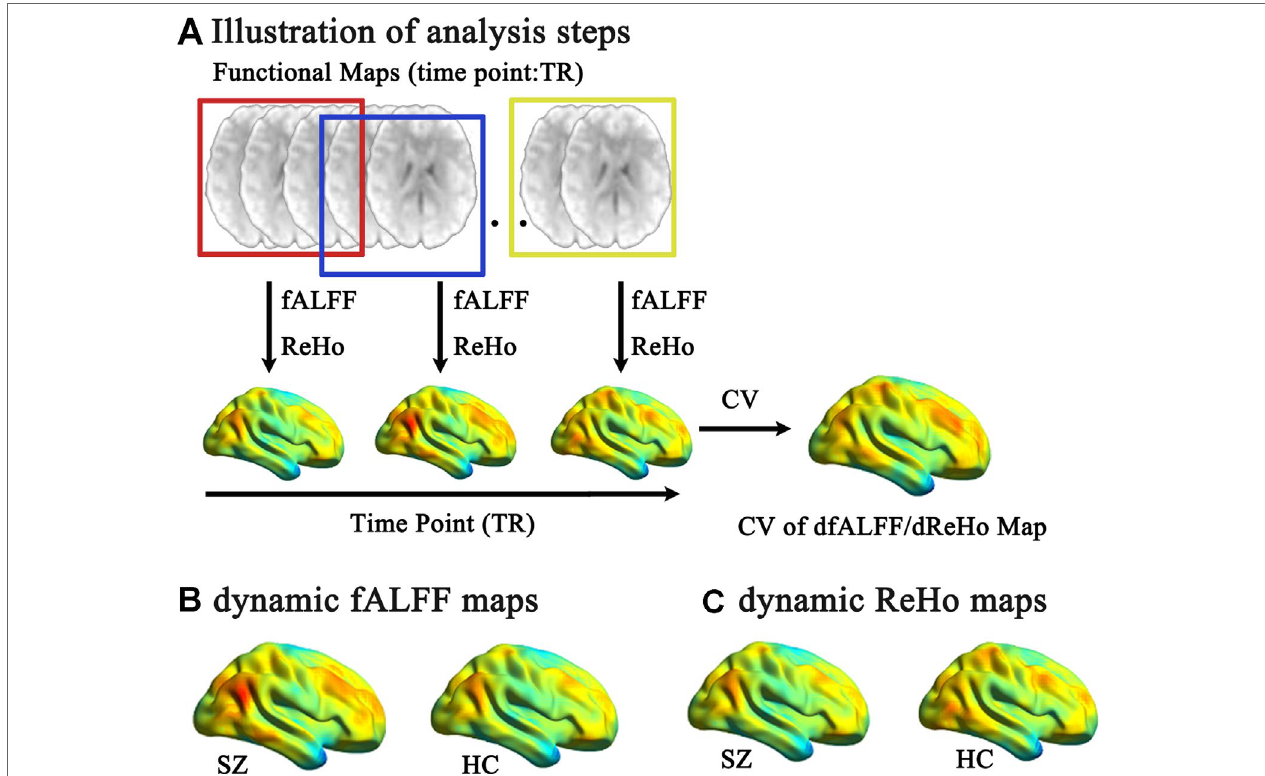
FIGURE 1 | Illustration of analysis steps and temporal variability of dynamic fALFF and ReHo pattern. (A) The preprocessed full-length blood oxygen level- dependent fMRI maps were segmented into several sliding windows (50 TR). Within each window, the fALFF and ReHo were computed for each voxel. The sliding window was systematically shifted by one TR, and the corresponding fALFF and ReHo were computed. Then, the temporal variability of the dynamic fALFF and ReHo were defined as the CV maps across the sliding windows. The pattern of temporal variability of the fALFF (B) and ReHo (C) of the schizophrenic subjects/ healthy controls were